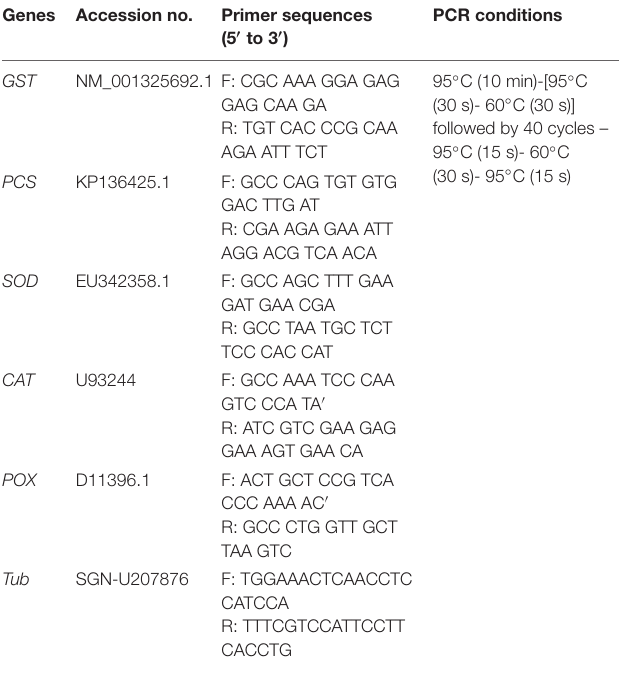
TABLE 1 | Primer sequences and PCR conditions used for qRT-PCR analysis in this experiment. Genes Accession no. Primer sequences (5 (cid:48) to 3 (cid:48)